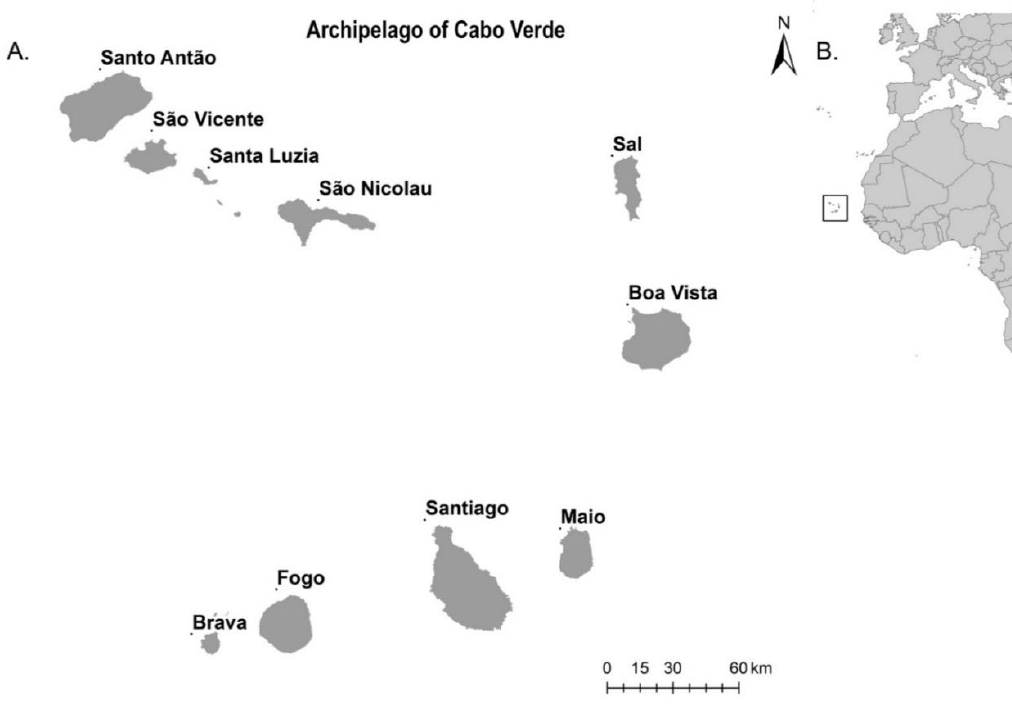
Figure 1. Geographic localization of Cabo Verde archipelago ( A ), islands’ distribution in the archipelago; ( B ), regarding the West Coast of Africa).